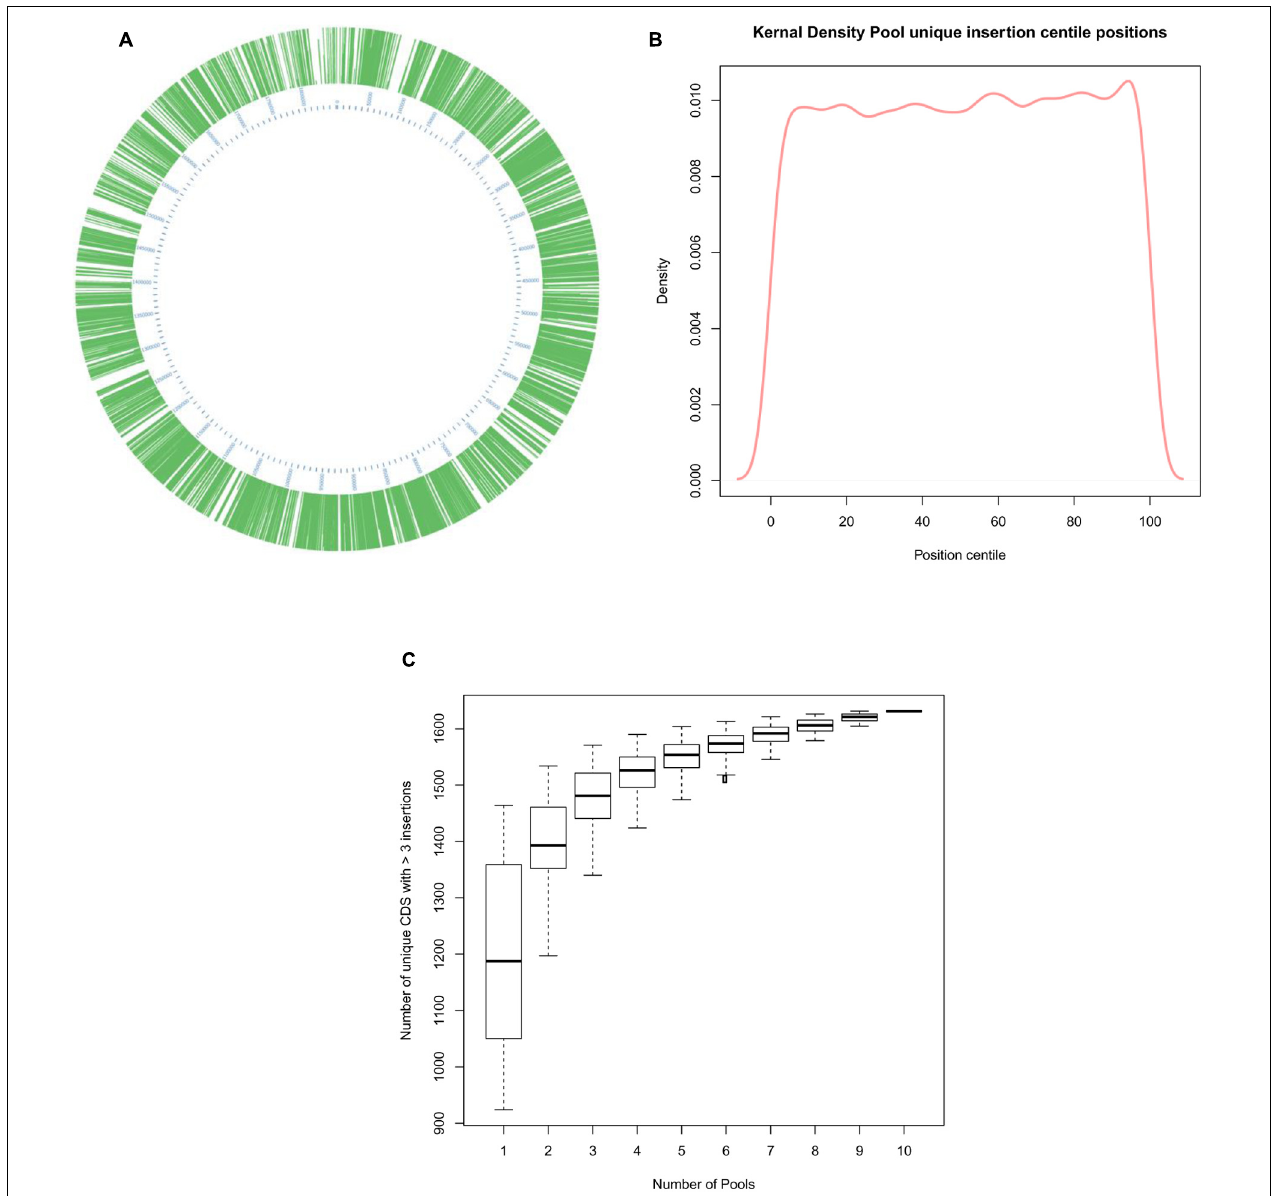
FIGURE 4 | Analysis of > 80,000 unique insertions detected within the genome of S. uberis following PIMMS. (A) Circos graphical representation (Krzywinski et al., 2009) of the distribution of unique insertions identified within the S. uberis genome. (B) Kernal density plot displaying the proportion of individual mutations identified each centile position of mutated CDS within the S. uberis genome. (C) Box and whisker plot showing inter quartile range (box), median (line) and range (whiskers) of unique insertions detected following a random permutation test (1000 permutations of 1 million randomly selected sequence reads from each pool were used to calculate mean number of disrupted CDS that may be detected from any 1 of 10, 2 of 10, 3 of 10, etc. to 10 of 10